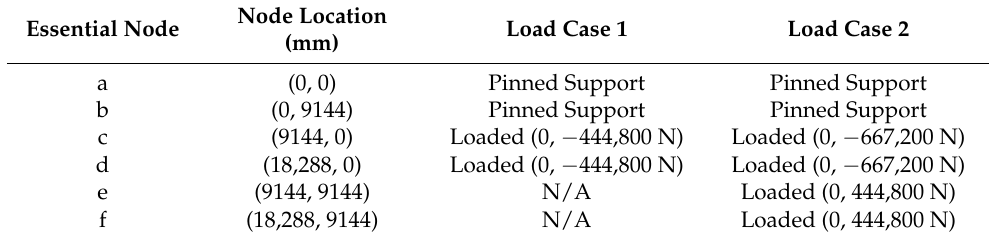
Table 4. Essential node information in experiment 2.